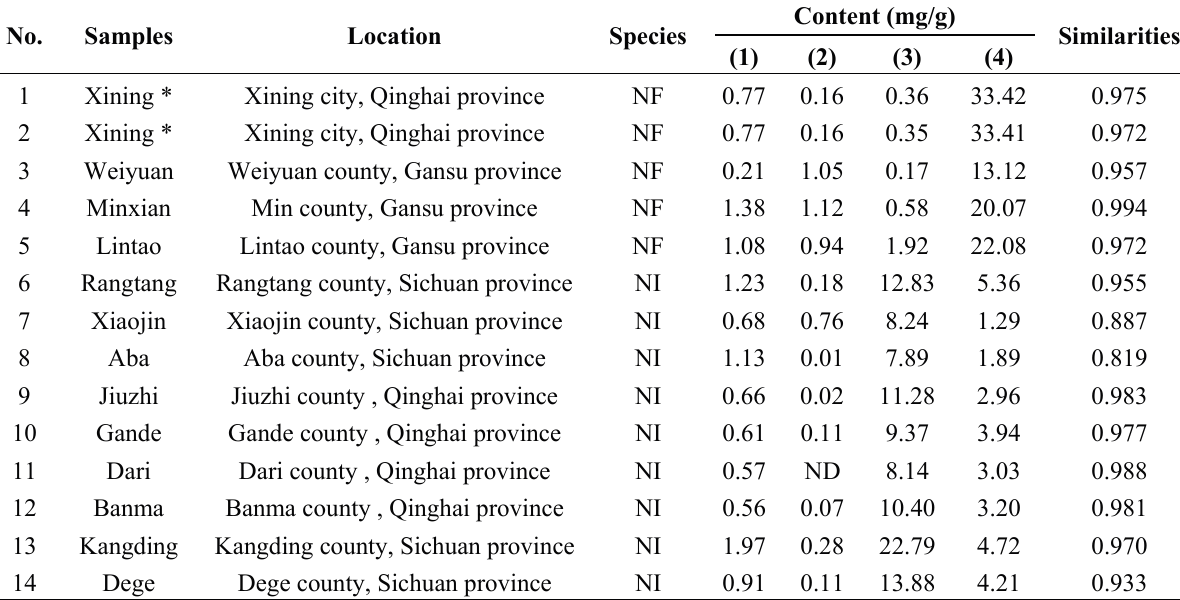
Table 2. Sample list: contents of the 4 compounds in Qianghuo (14 batches) and fingerprint